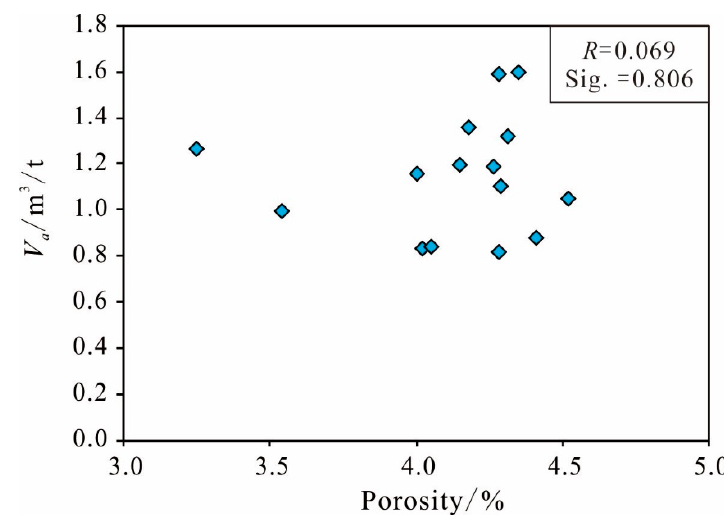
Figure 19. No obvious relationship between V a and porosity.